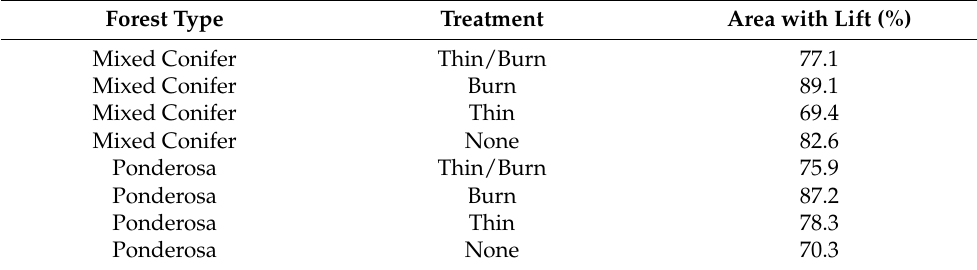
Table 3. Percentage of area in each sample unit with a predicted CBH lift of any magnitude; ponderosa pine and dry mixed-conifer forest types on the Malheur National Forest near John Day, OR,